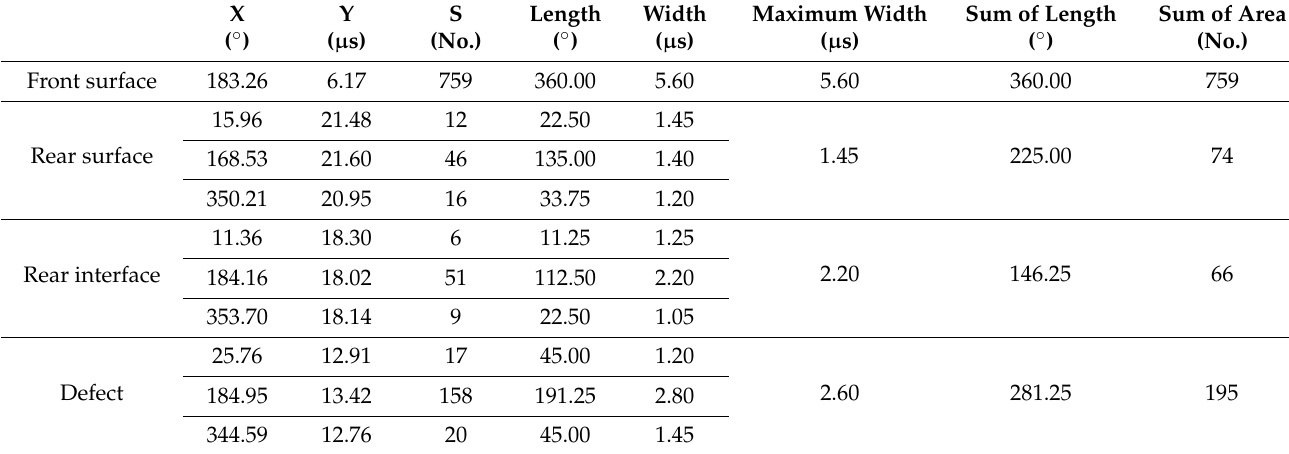
Table 2. Geometric feature information of selected transverse crack defect image.